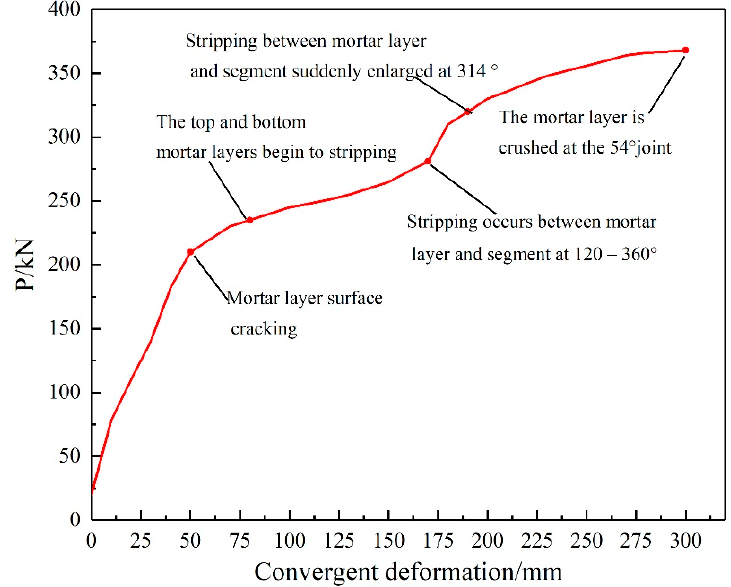
Figure 15. Load–convergence deformation of the strengthened